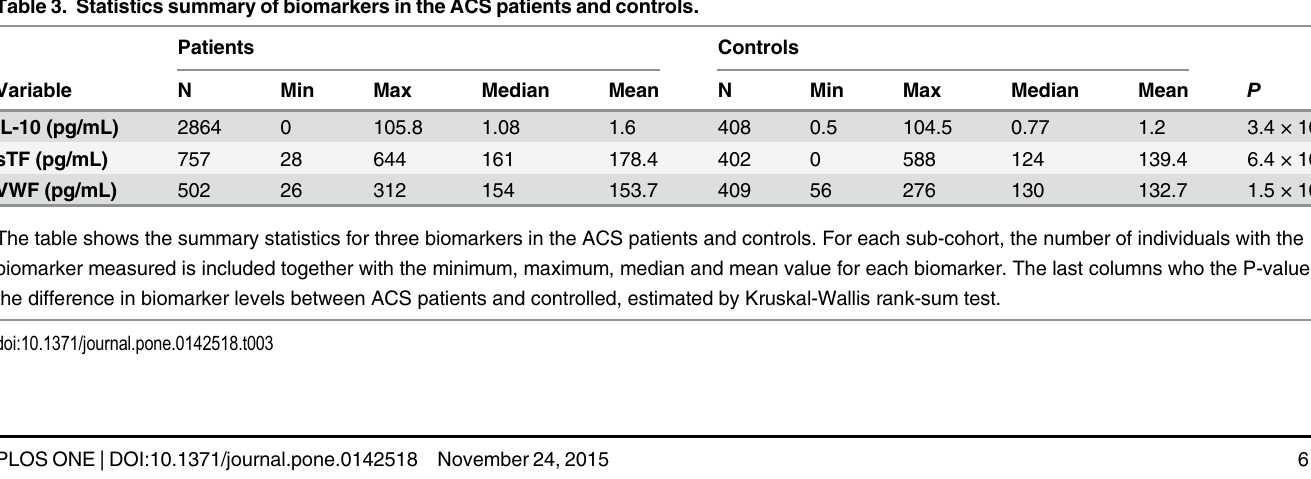
Table 3. Statistics summary of biomarkers in the ACS patients and controls. Patients